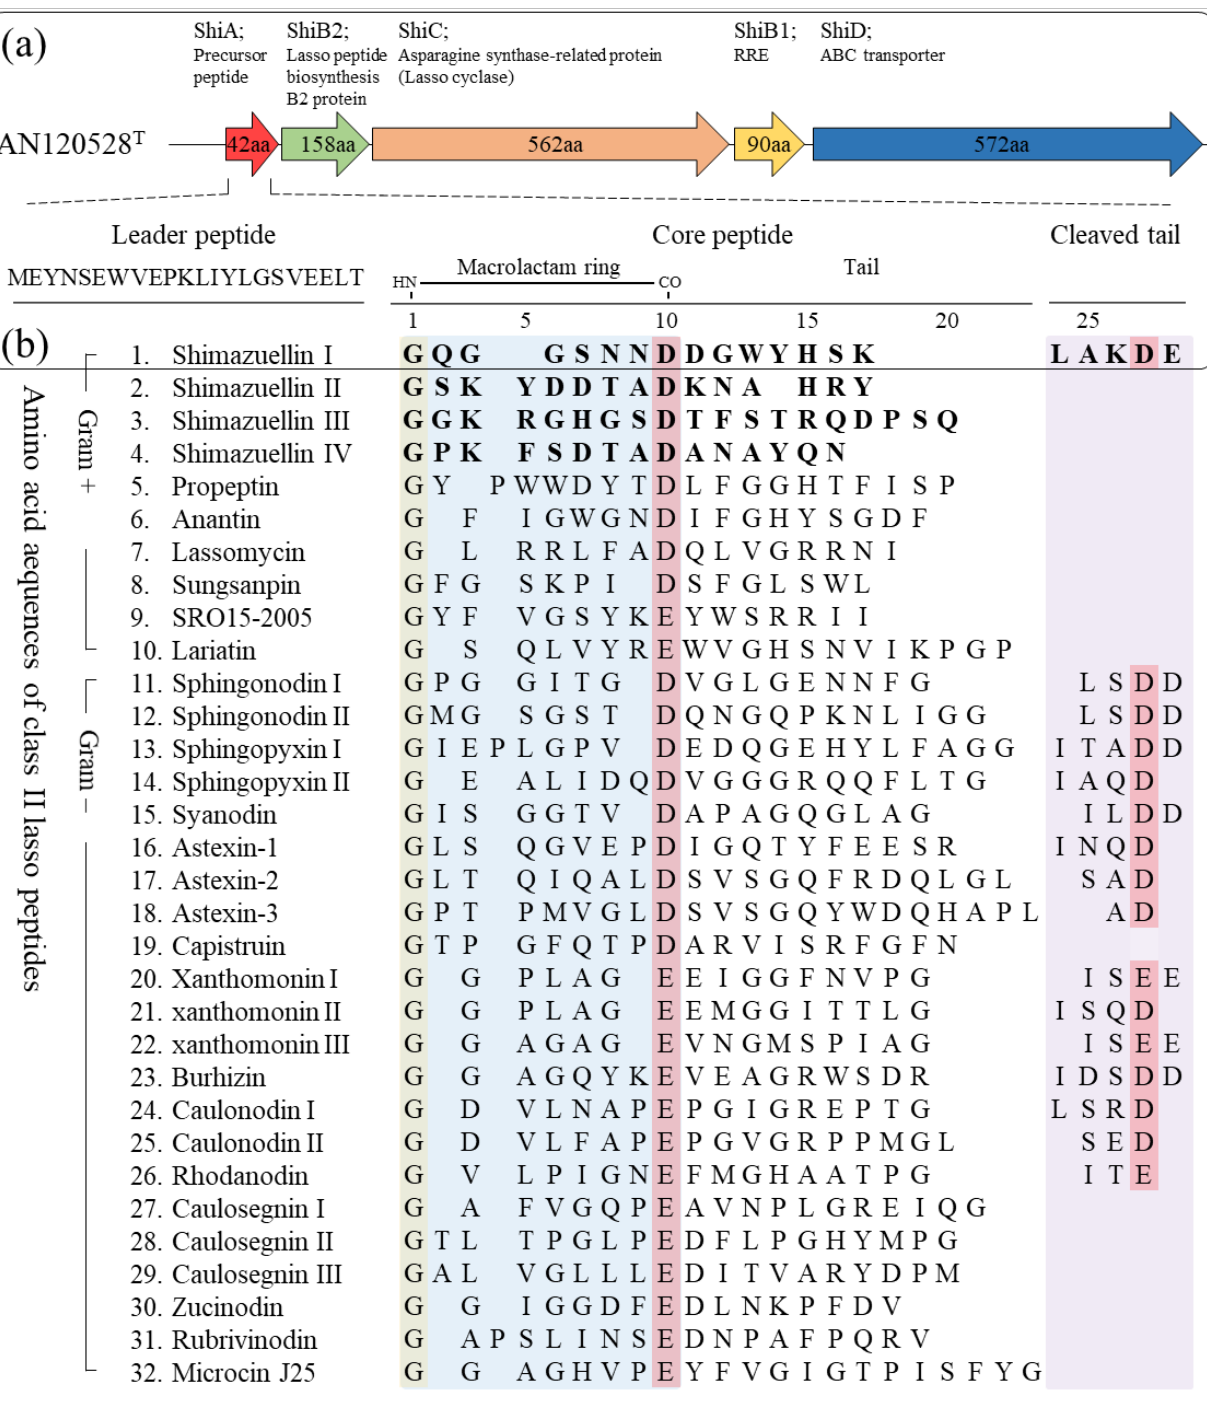
Figure 4. Gene organisation in the lasso peptide cluster of AN120528 T and other core peptide sequences of class II lasso peptides. ( a ) Shimazuellin biosynthetic gene locus. ( b ) The putative leader and core regions of Shimazuellin with other related lasso peptides.